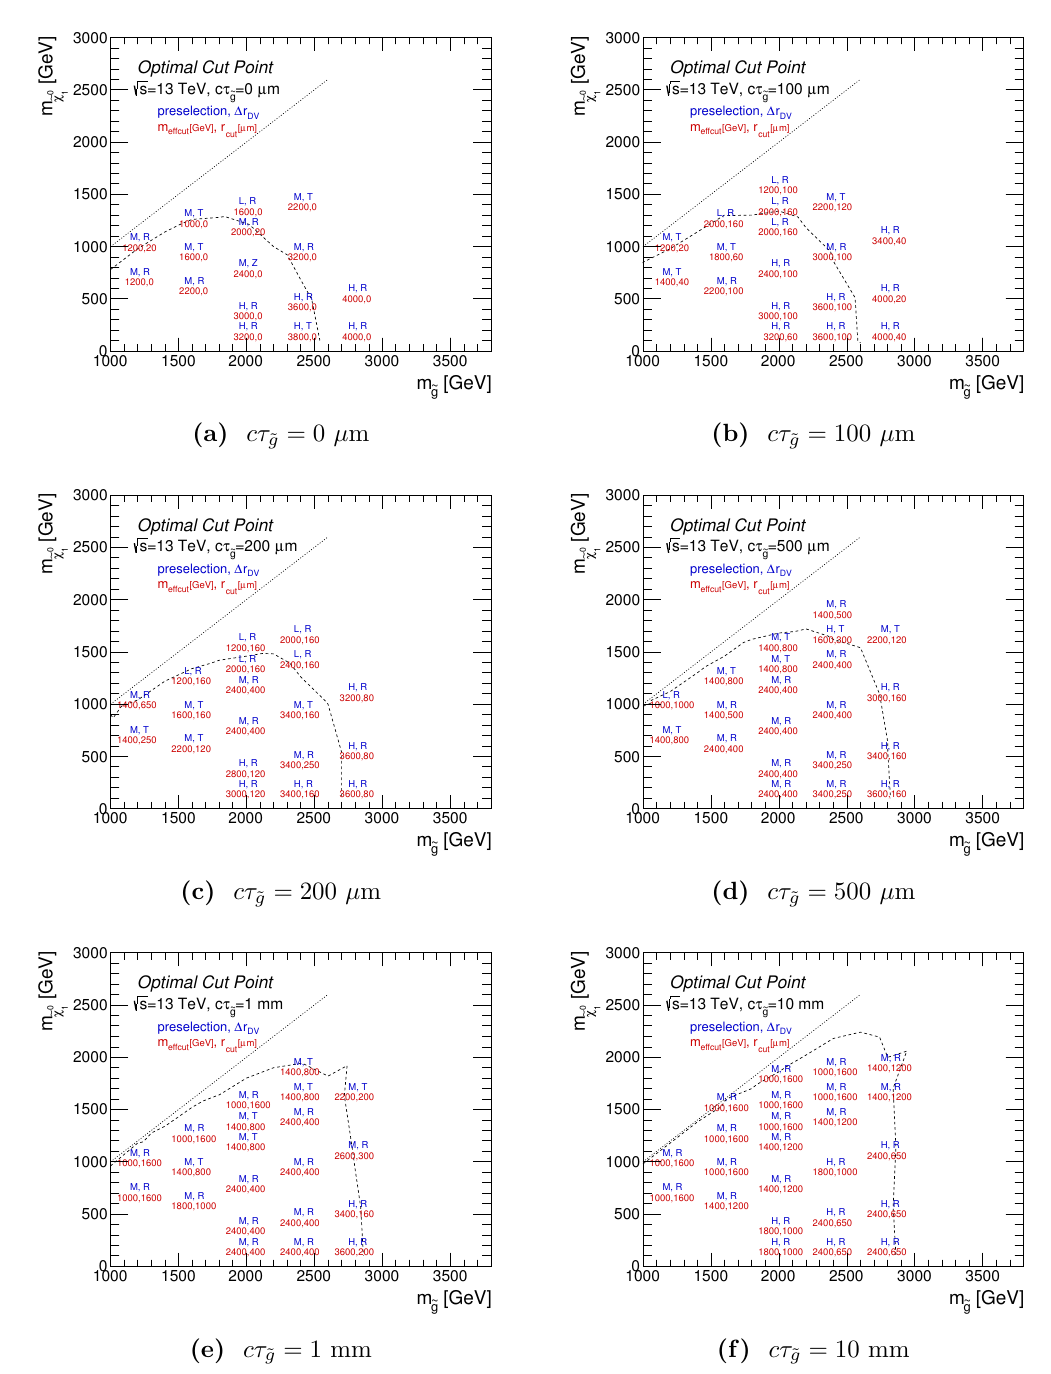
Figure 7. Optimal cut values (( m L , M , H ), and the e(cid:11)cut ) optimal , ( r cut ) optimal ), the preselection ( discriminator (cid:1) r DV ( R , T , Z ) for each sample point with various c(cid:28) ~ g , with an integrated luminosity of 3000 fb (cid:0) 1 . The expected 5 (cid:27) discovery reaches for gluinos are also shown in the dashed